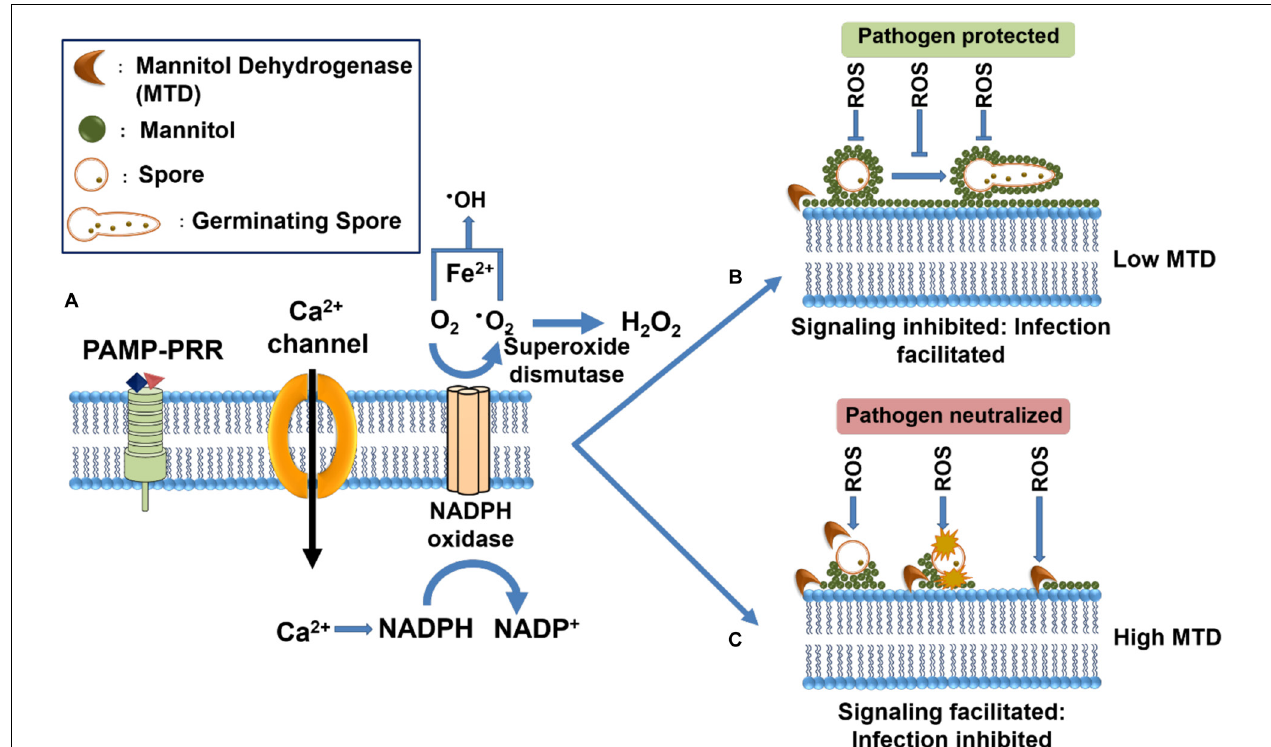
FIGURE 5 | Illustration of the influence of Mannitol and Mannitol dehydrogenase in mediating plant defense responses. (A) Recognition of fungal PAMPs in the host apoplastic space triggers PTI mediated oxidative burst which is characterized by the activation of a membrane-bound NADPH oxidase, leading to the generation of reactive oxygen species (ROS) superoxide ( • O 2 − ), which is subsequently converted into hydrogen peroxide (H 2 O 2 ) and hydroxyl radical ( • OH). (B) The filamentous pathogens secrete mannitol in response to mannitol dehydrogenase oxidative burst to mitigate host mediated oxidative burst through the formation of a protective shield around the fungal structures. (C) Several plants have been seen to secrete a mannitol catabolic enzyme, mannitol dehydrogenase (MTD) that can metabolize the fungal mannitol, thereby restoring the ROS-mediated responses and including antimicrobial effects (Adapted from Patel and Williamson, 2016 and reproduced with permission from